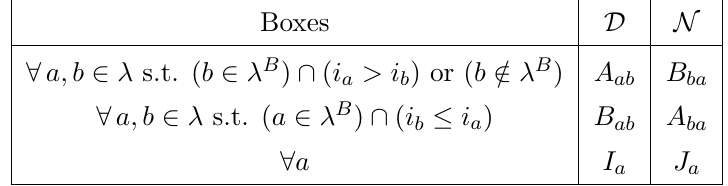
Table 1. Exceptional Dirichlet boundary condition associated to vacuum λ